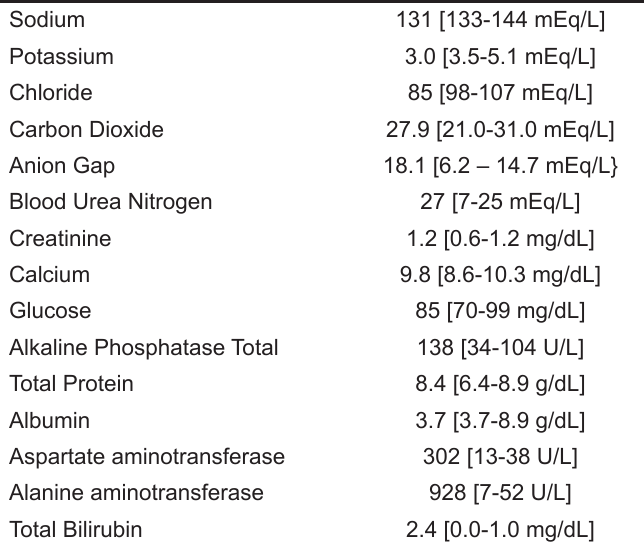
Table 2. Complete metabolic panel of an 18-year-old pregnant woman with